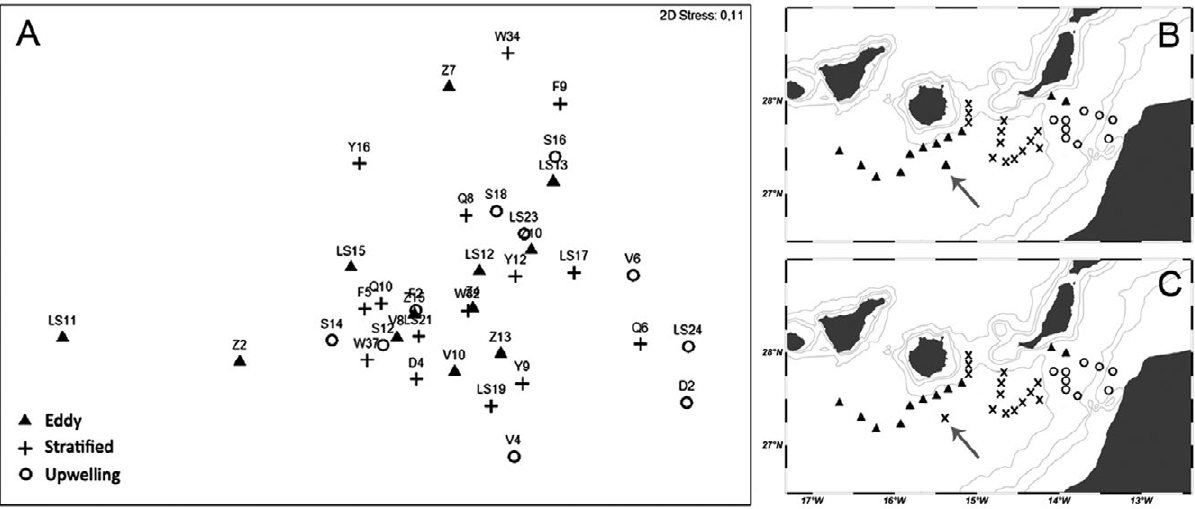
Fig. 7. – Non-metric multidimensional scaling (nMDS) plot showing sample assemblages based on a Bray-Curtis similarity matrix of the larval abundances of decapods (A). Spatial distribution of the environmental (B) and decapod larvae assemblages (C) in the C-ACTZ. Grey arrow highlights the only station without assemblage matching.